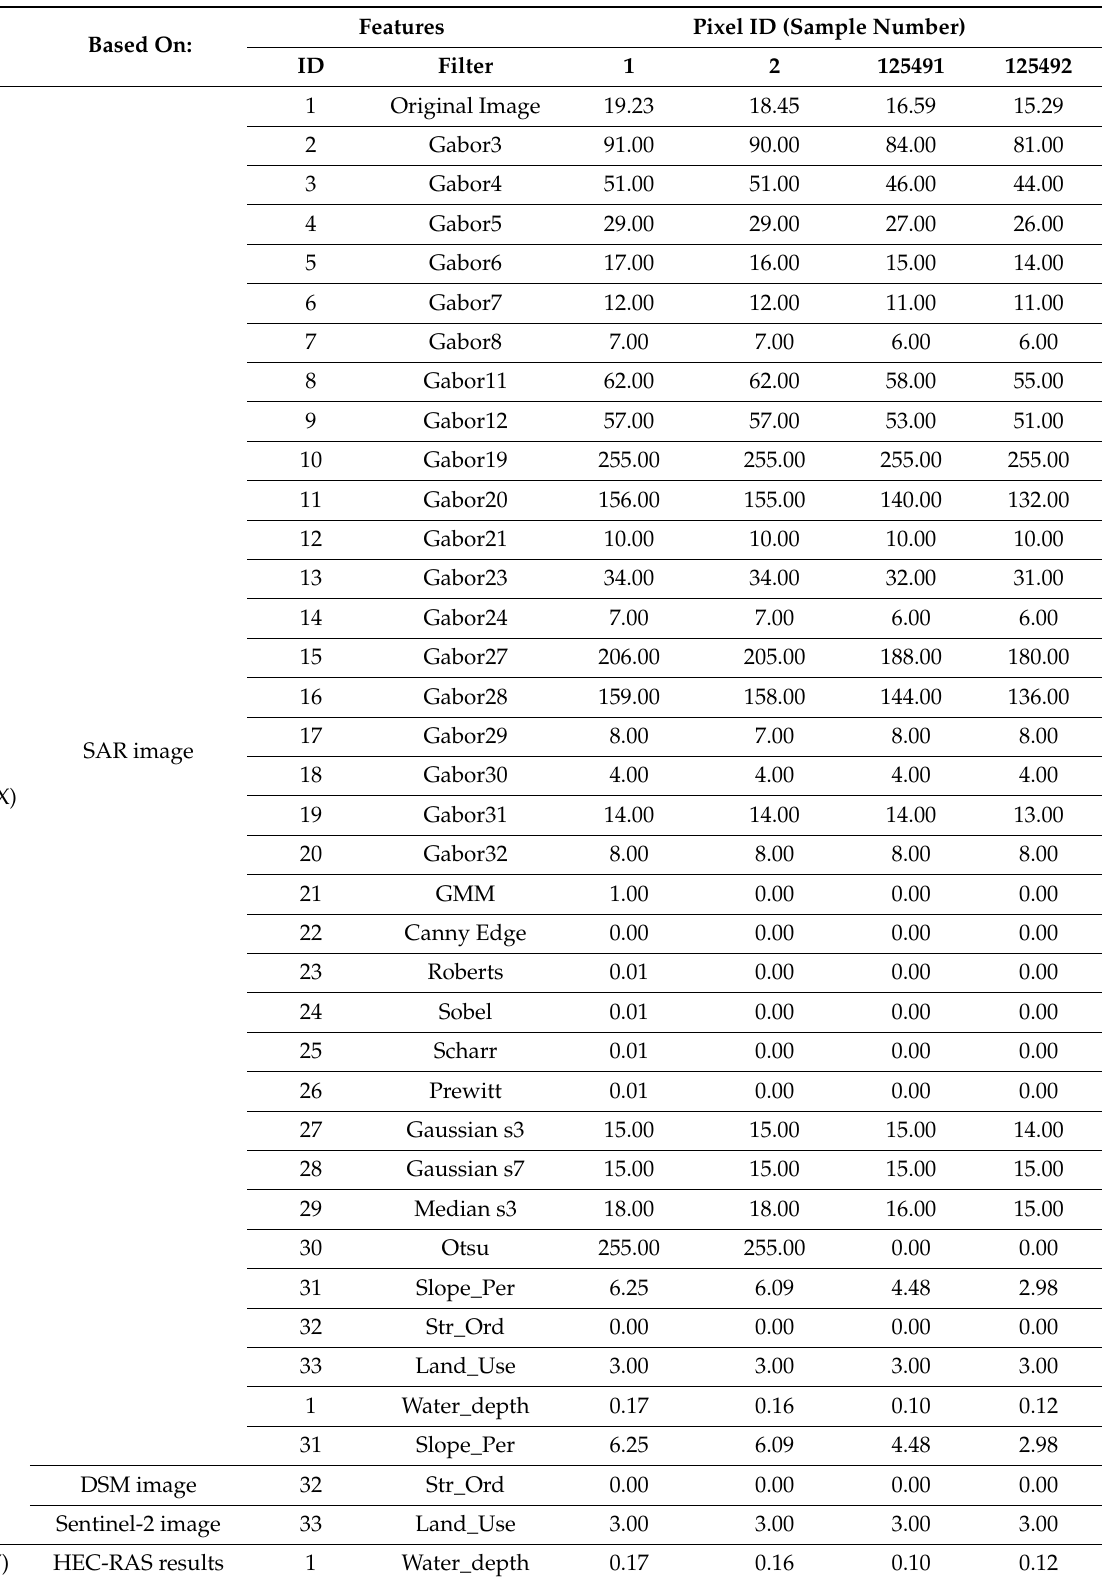
Table 2. Sample of the extracted feature